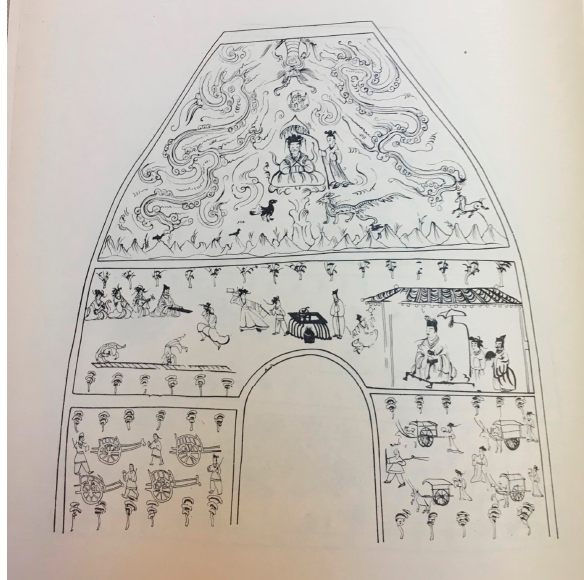
Figure 17. Schematic drawing of west wall, Dingjiazha M5, Later Liang to Northern Liang dynasties (386–441). (Gansusheng Wenwu Kaogu Yanjiusuo, Figure 19). ©Wenwu Press. This figure published with permission of Wenwu Press and cannot be used or copied without their permission.